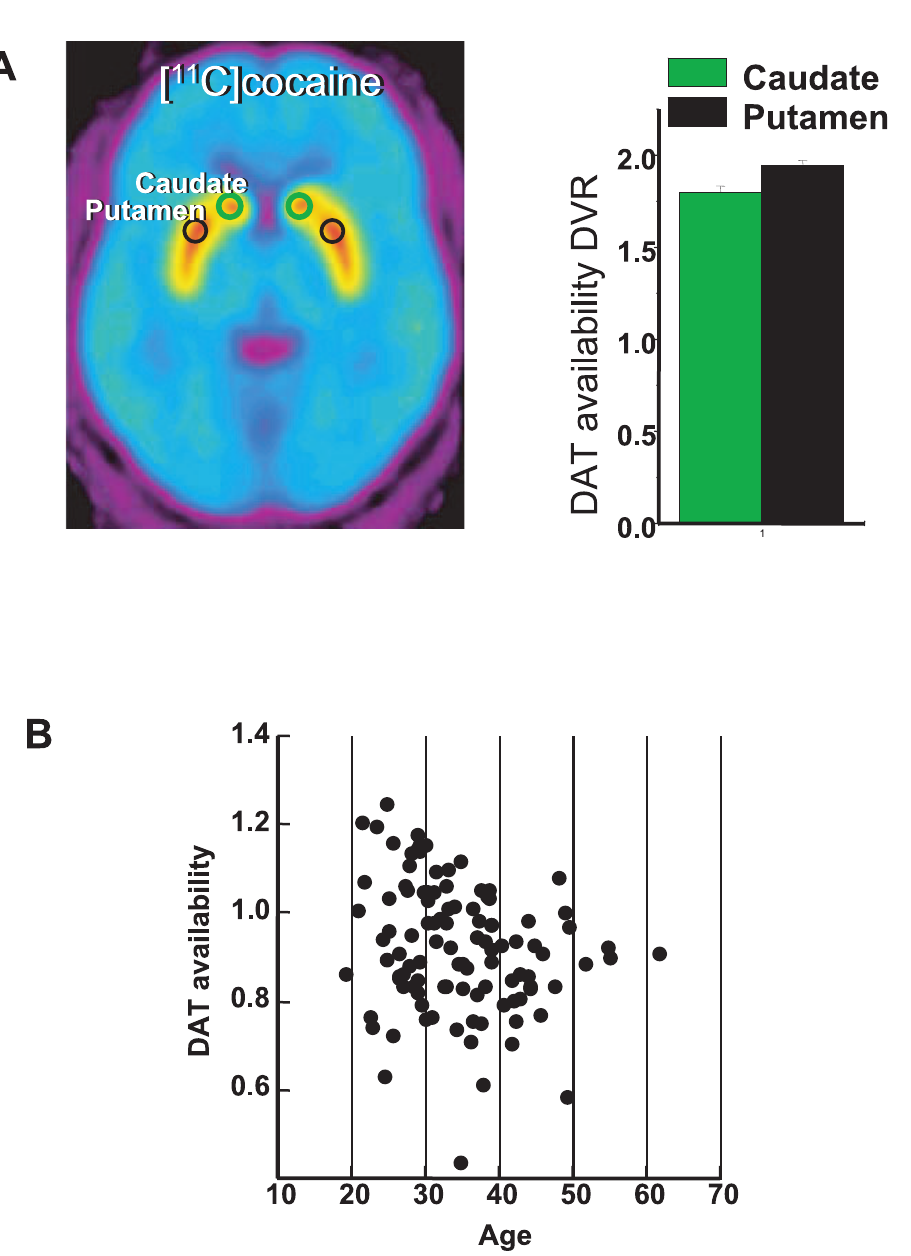
Figure 1. Variability of the dopamine transporter. A - DAT distribution in the brain. Averaged DVR [ 11 C]cocaine image at the level of the striatum and ROI measures of DAT availability in caudate and putamen. Values represent means 6 standard deviations across 14 healthy men. B - DAT availability in the striatum of healthy controls of different ages. Measures were obtained with PET and [ 11 C]cocaine and quantified as Bmax/Kd (using Logan plots for irreversible systems). Note the range of variation in DAT availability across